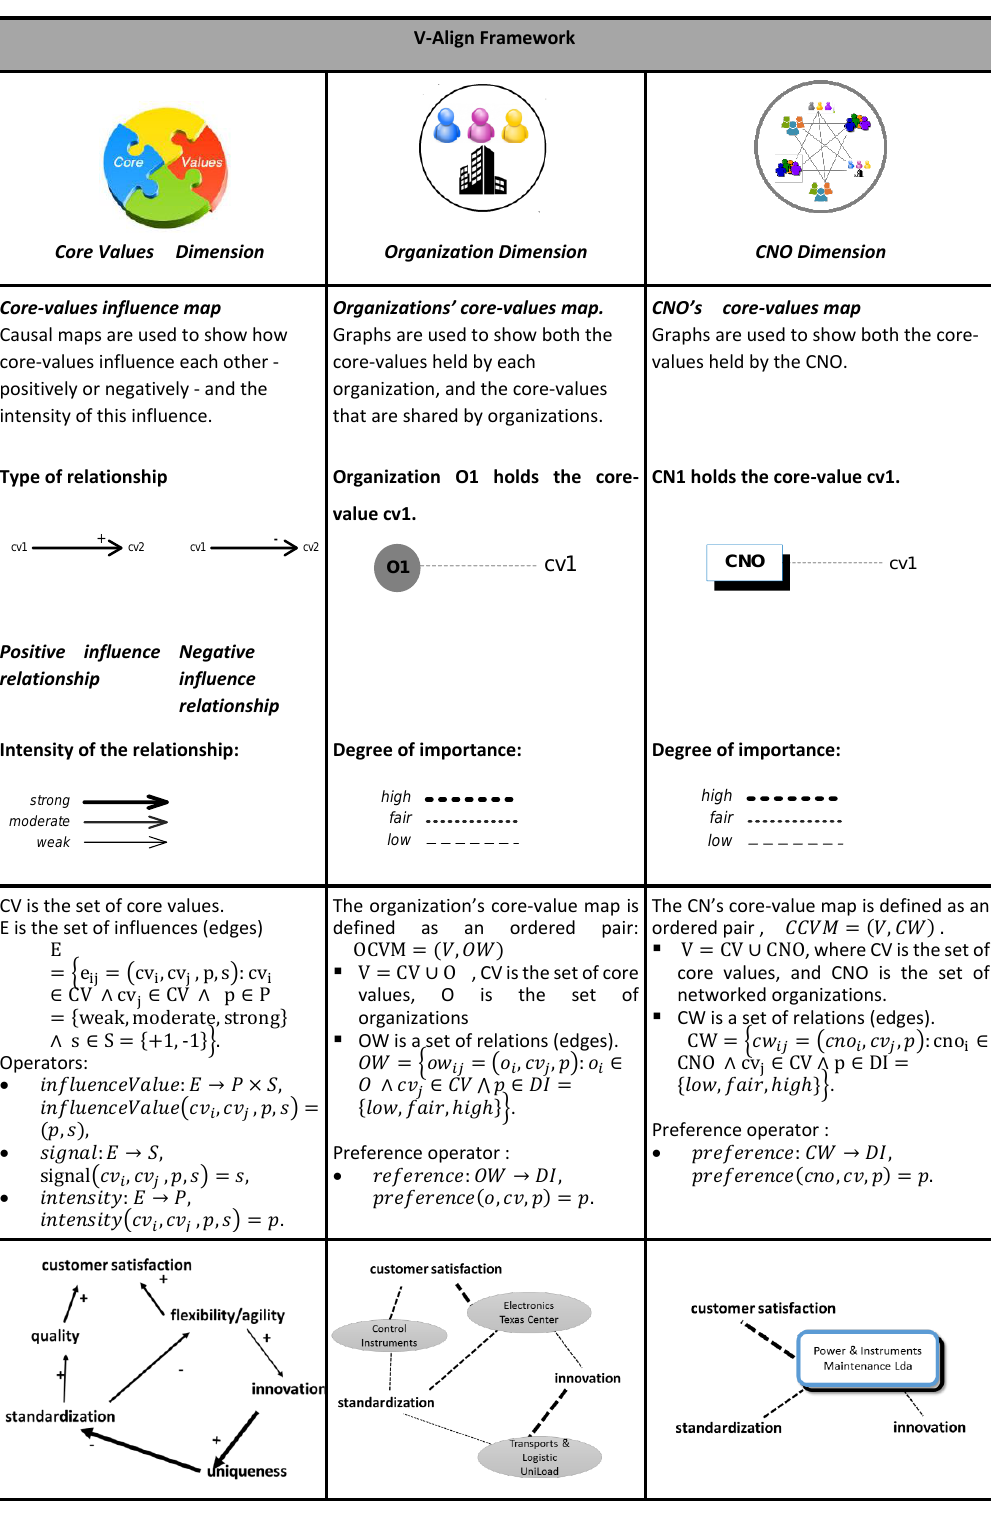
Figure 2. V-Align Framework overview.